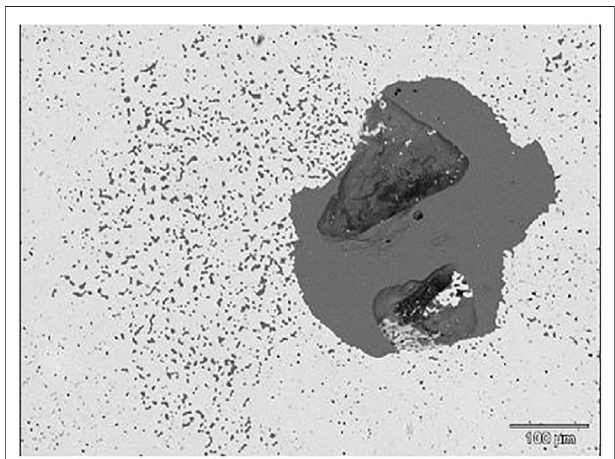
FIGURE 3 | XCT ortho slice of a pre-melted powder press sample showingtheinclusionindarkgrey,steelmatrixinlightgreyanddarkerspotsof porosity within the steel matrix and inclusion.